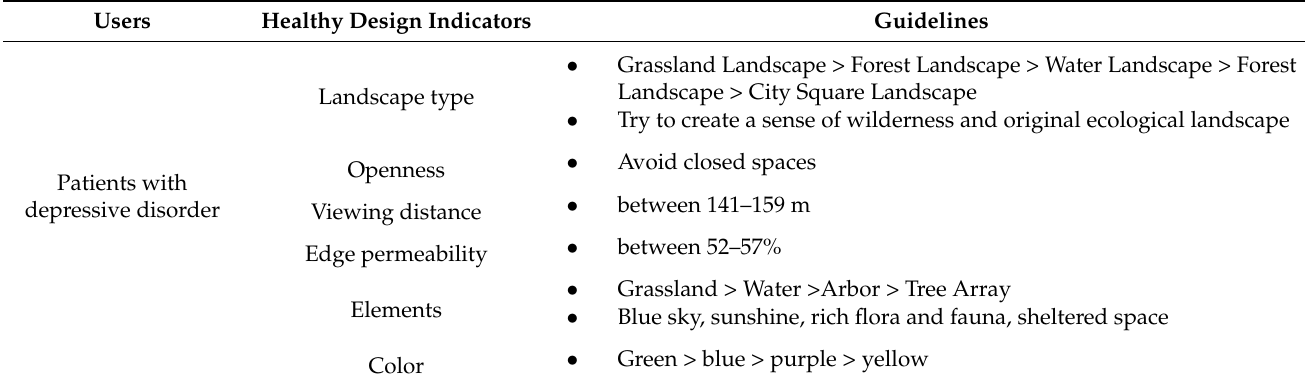
Table 20. Guidelines for healthy landscape design for patients with general depressive